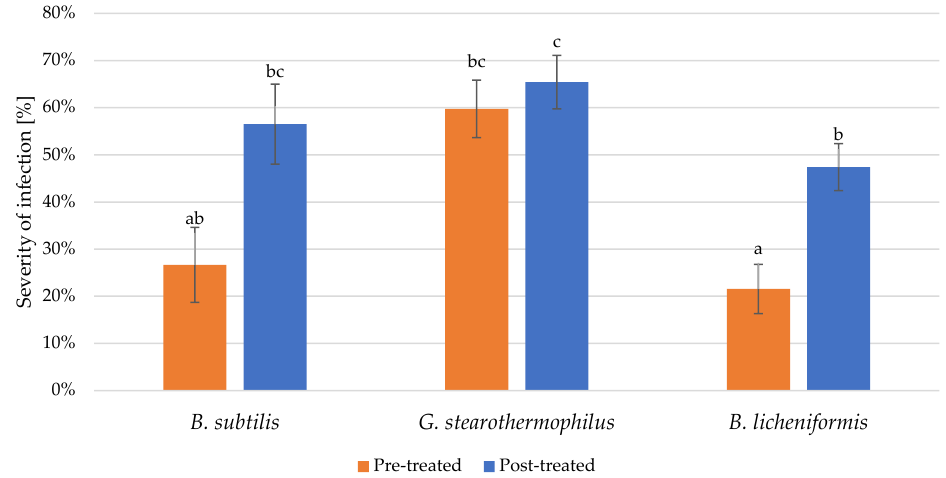
Figure 5. Disease severity of A. alternanta pre-treated and post-treated by biosurfactant comparing mean significance with Tukey HSD. Small letters indicate the statistically different results groups.